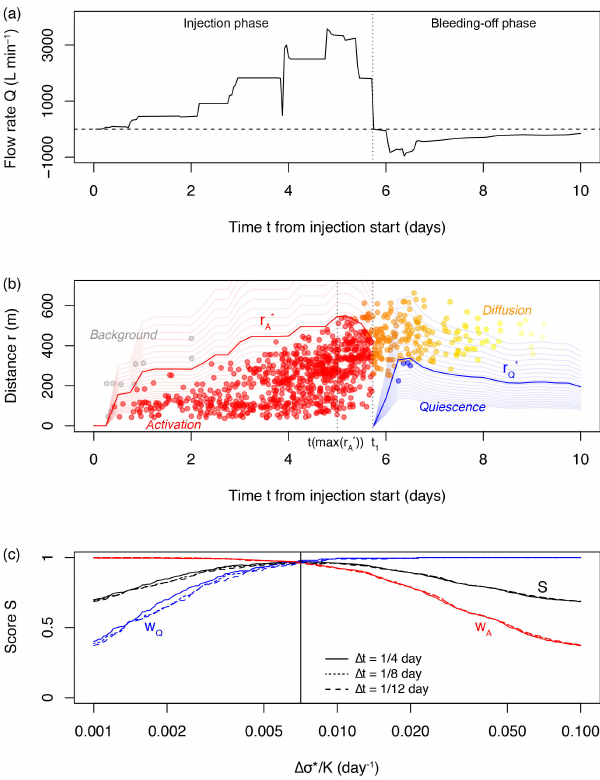
Figure 2. 2006 Basel EGS stimulation experiment data with acti- vation and quiescence envelope fits: (a) flow rate Q(t) (digitised from Häring et al., 2008); (b) spatio-temporal distribution of re- located induced seismicity (Kraft and Deichmann, 2014) with r the distance from the borehole. The activation and quiescence en- (t) and r ∗ (t) are defined from Eq. (13) with parame- velopes r ∗ A Q ters d (cid:49)σ ∗ = 0.007day − 1 (dark curves) and (cid:49)t = 1 / 4 day. The light curves represent the range d (cid:49)σ ∗ ∈ [ 10 − 3 , 10 − 1 ] day − 1 in 0.1 in- crements on the log 10 scale. Points represent the induced earth- quakes; which colour indicates how they are declared. (c) Score S = (w A + w Q )/ 2, with w A and w Q being the ratio of events of distance r ≤ r ∗ and r ≥ r ∗ in the injection and bleeding-off phases, A Q respectively. The vertical line represents d (cid:49)σ ∗ = 0.007day − 1